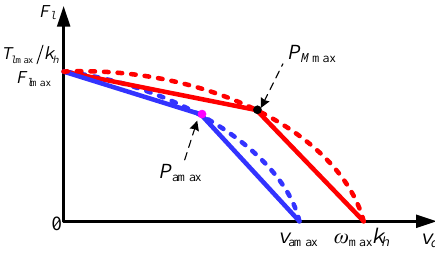
k . Figure 14. Matching actuator power requirement with motor by constant k h . h